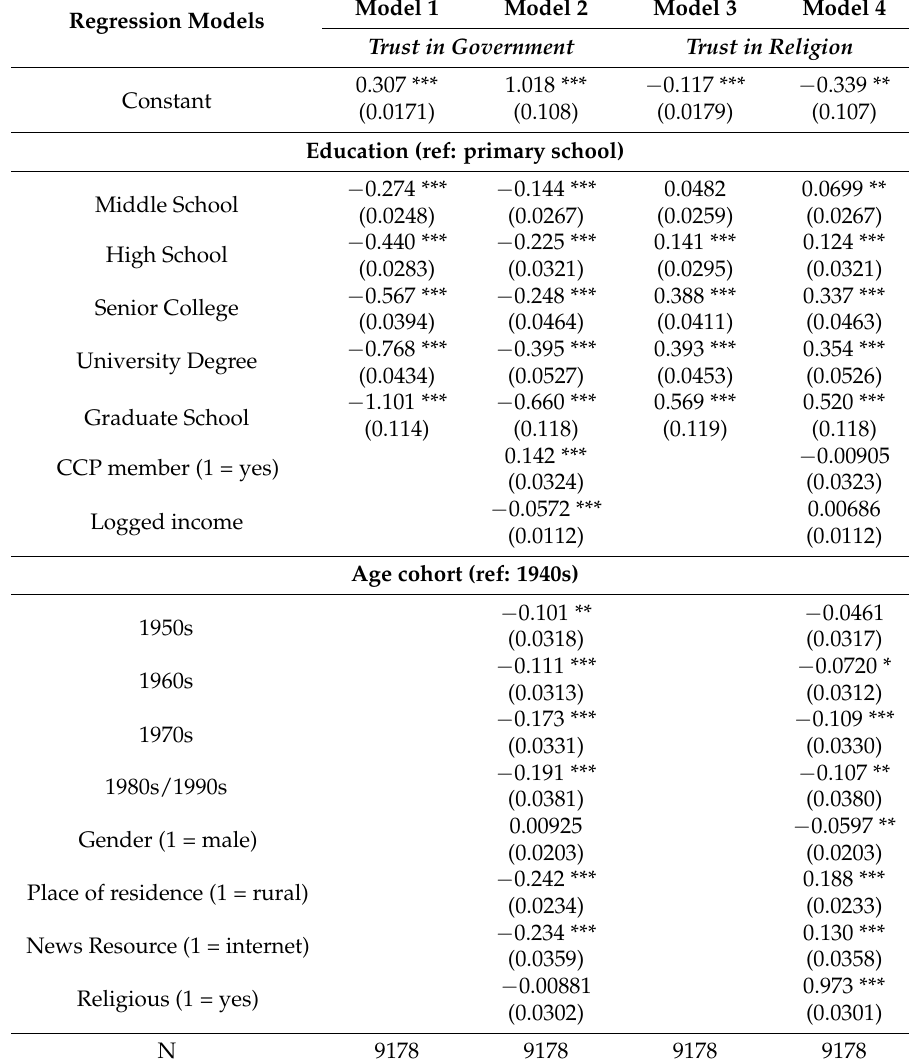
Table 3. ordinary least squares (OLS) regression models of trust in government and trust in